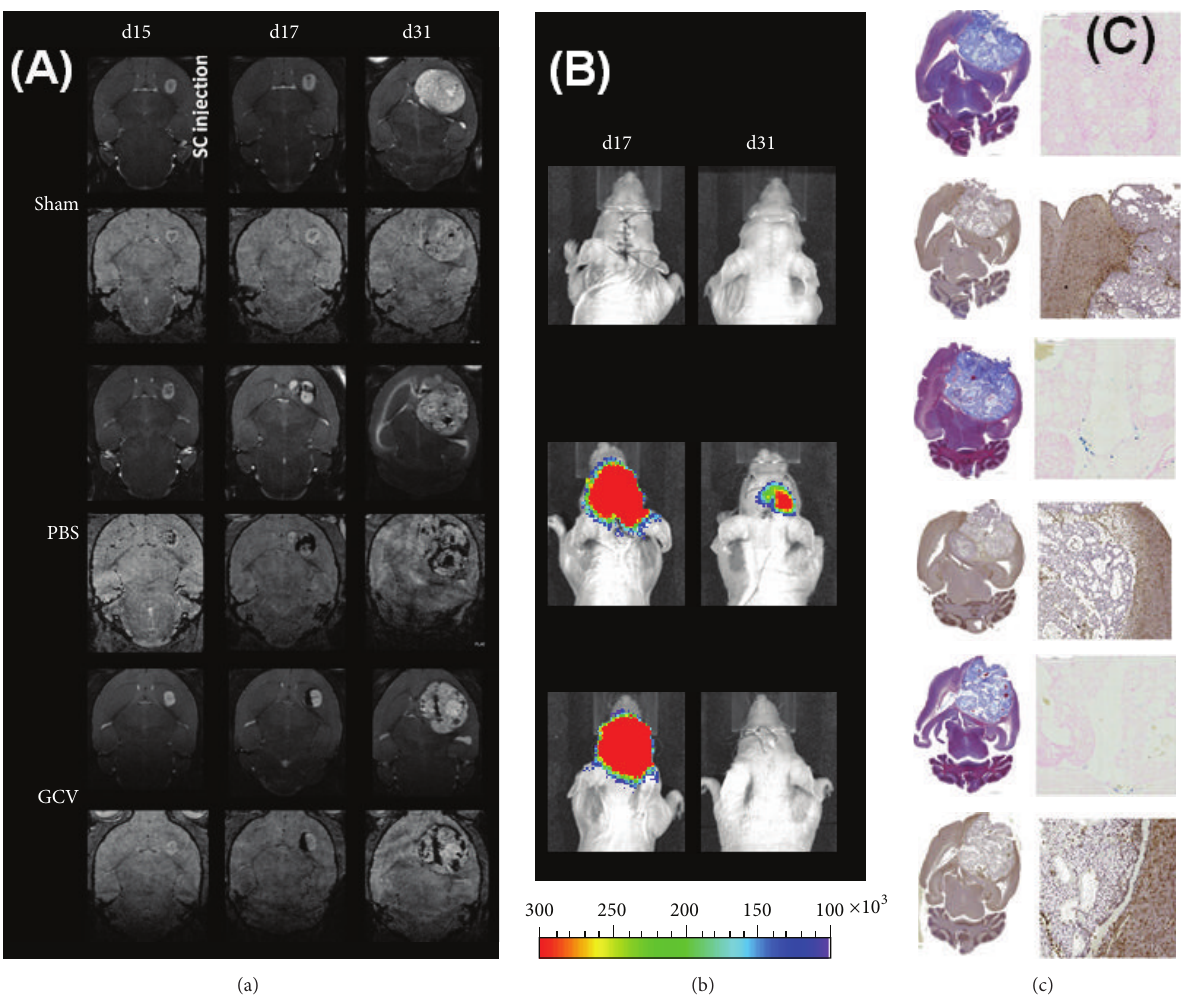
Figure6:Follow-upofsuicidegenetherapyusinghMultistemascellularvehiclesintheHs683oligodendrogliomamodelbyusingmultimodal in vivo imaging and histology. (a) MR images of a representative animal from the sham, PBS, and GCV treated groups show a comparable tumor growth prior to hMultistem injection on T 2 -weighted MR images (upper row for each group). While there is little hypointense contrast visible on 3D T ∗ 2 -weighted MR images (lower row for each group), the distribution of SPIO labeled hMultistem cells could clearly be detected due to their hypointense contrast in the PBS and GCV treated group. When tumors grew larger, the hypointense voxels got more dispersed over time. (b) BLI of representative animals. The fLuc expression of the stem cells was clearly detectable after engraftment and only diminished after 14 days. (c) One week after the end of therapy, animals developed symptoms after which histological analysis was performed. Masson’s trichrome staining (upper left) of all animals showed very large tumors. Prussian blue (upper right) staining was also performed which confirmed the presence of iron in PBS and GCV treated animals. Finally, Iba1 staining (bottom) was performed which showed a predominant absence of activated microglia in all treatment groups. Some minor microglial activation was however detectable around the